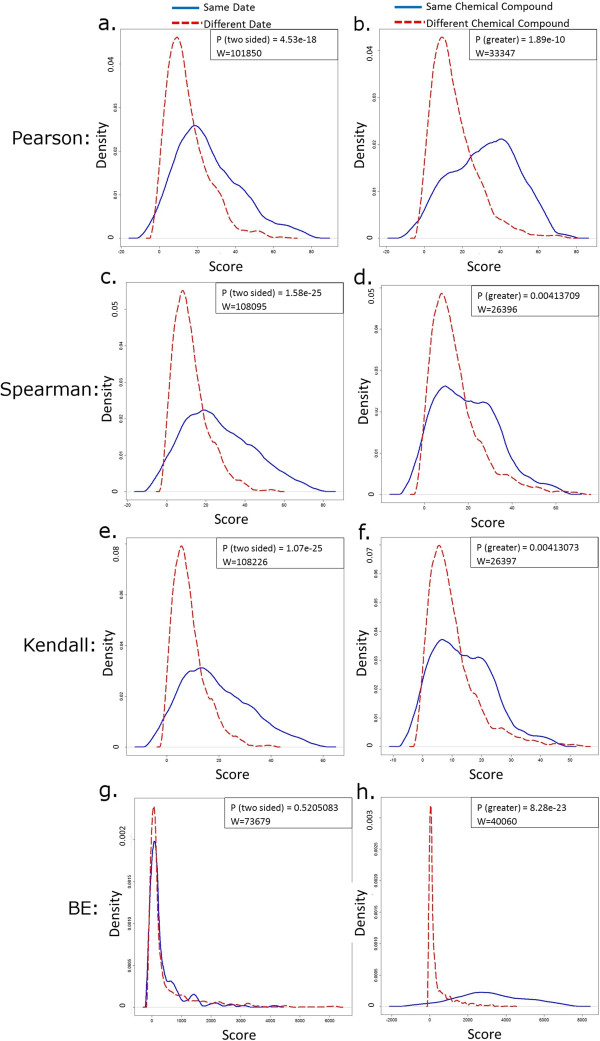
Shabtai et al. Four correlation score distribution outcome of TAG4 Microarray dataset. The BE algorithm is least affected by the experiment date and most affected by experiment’s chemical compound used. The graphs show the distribution of scores. The graphs on the left column represent results affected by date (a, c, e, g). The solid blue line represents the score distribution of experiment pairs performed on identical dates, and the fragmented red line represents the score distribution of experiment pairs performed on different dates (a, c, e, g). The distributions according to date are significantly diverse for Pearson, Spearman and Kendall correlations (a, c, e), whereas the distributions by date are similar for BE correlation (g), meaning the scores were highly comparable for experiments done on the same date compared to experiments done on different dates. The graphs on the right column represent the score distributions affected by chemical compound (b, d, f, h). The solid blue line represents the score distribution of experiment pairs using identical chemical compounds, and the fragmented red line represents the score distribution of experiment pairs using different chemical compounds. All methods show that the distribution of the same chemical compound scores is significantly different than the distribution of different chemical compound scores, signifying, as expected, that all methods are affected by the chemical compound. The BE method shows the most significant difference in distribution compared to the other methods (h), being most affected by the chemical compound.